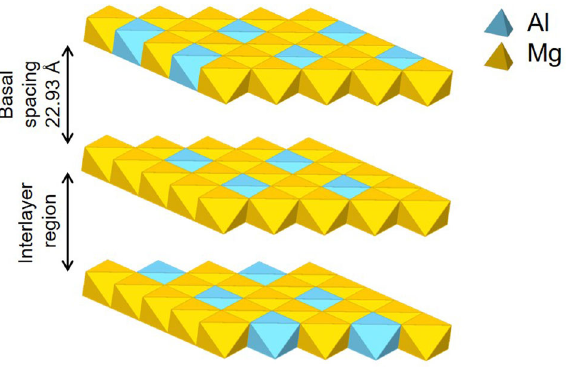
Fig. 8 Crystal structure of meixnerite (Mg 6 Al 2 (OH) 18 ·4H 2 O). High- lighting the layered double hydroxide structure, comprised of sheets containing [Mg 2 + (OH) 6 ] 4 − (yellow) and [Al 3 + (OH) 6 ] 3 − (cyan) tetrahedra, and interlayer regions where water and a wide range of anionic species can